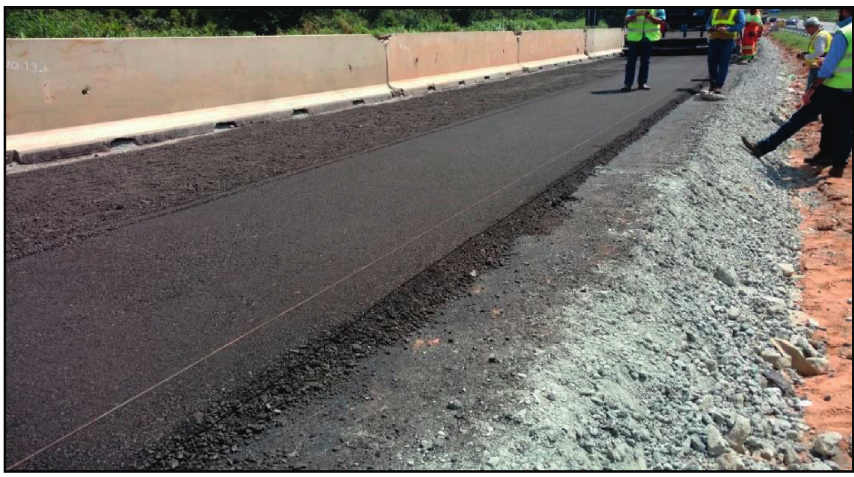
Figure 7: Construction of the first layer of the cold recycled